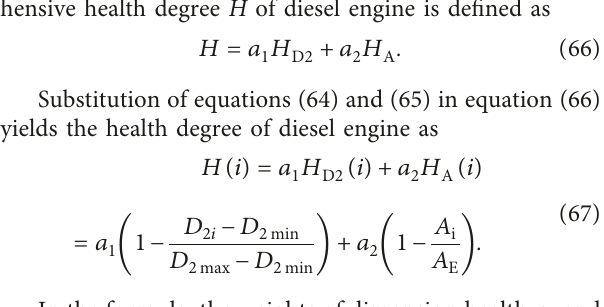
Figure 22: Fitting curve of health condition of 1,500r/min diesel engine.